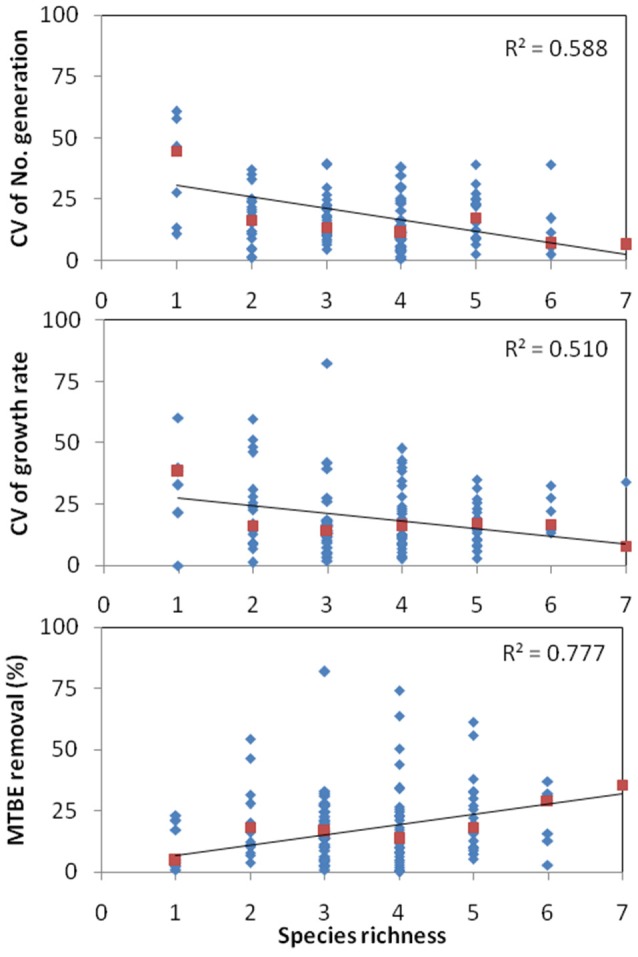
Effect of coefficient of variation (CV) of total community fitness (number of generations or growth rate) or function (MTBE removal) on microbial species diversity. The data shown is for MTBE grown communities. The lower coefficients of variation in rich diverse systems describe the stability of fitness or function by diversity. —CV of community, —Median CV for N species.